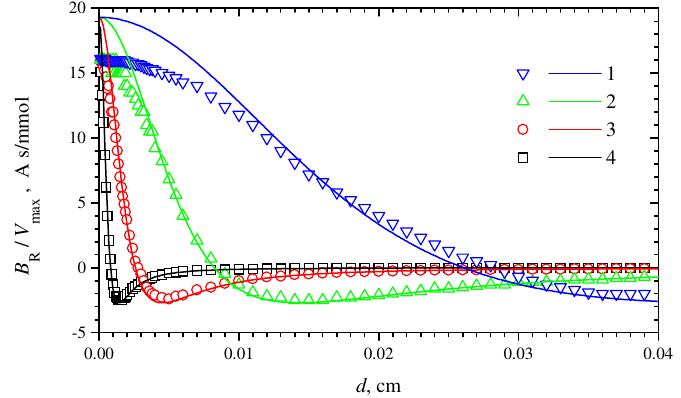
Figure 9 . The biosensor resistance B R (formula 21), normalised with the maximal enzymatic rate , versus the membrane thickness d . Symbols are numerical solutions, while lines are V max analytical ones (formula 14). All parameters are the same as in Fig